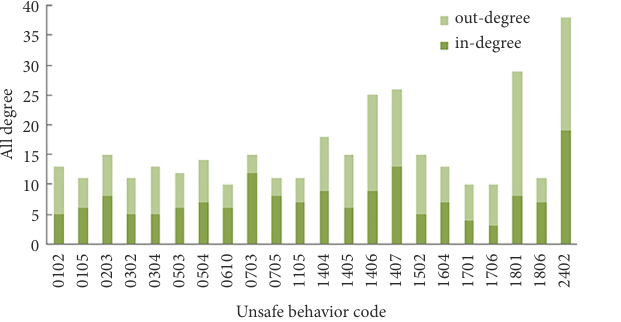
Figure 5. Nodes with all degree greater than or equal to 10